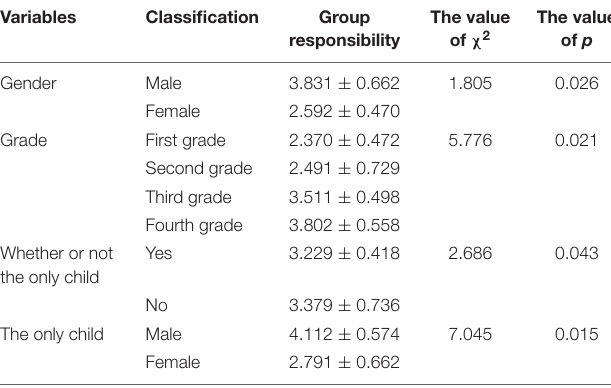
TABLE 5 | Analysis of the difference of group responsibility in general demographic variables.